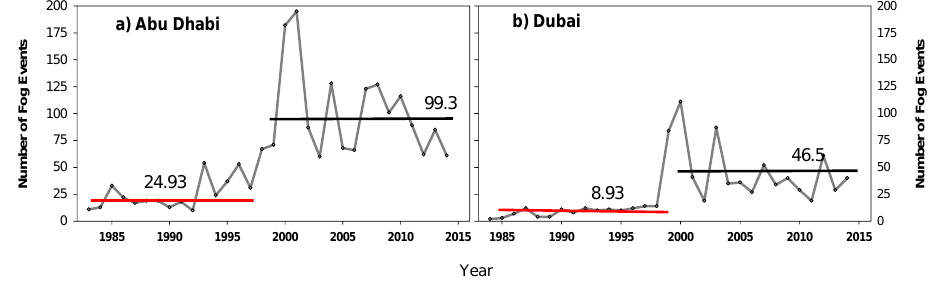
Figure 11. A homogeneity analysis for number of fog events in ( a ) Abu Dhabi and ( b ) Dubai cities.